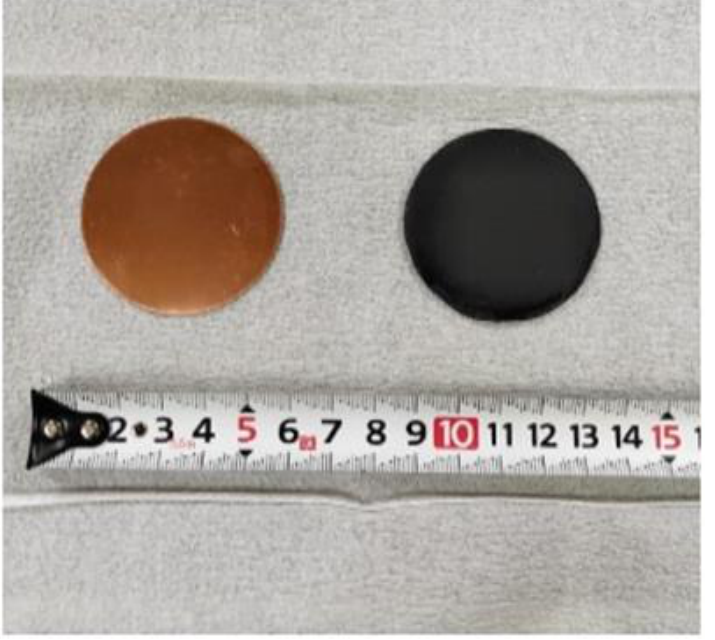
Figure 5. Photo of black body material prepared by this study and Cu solid disc before spraying black body spray.